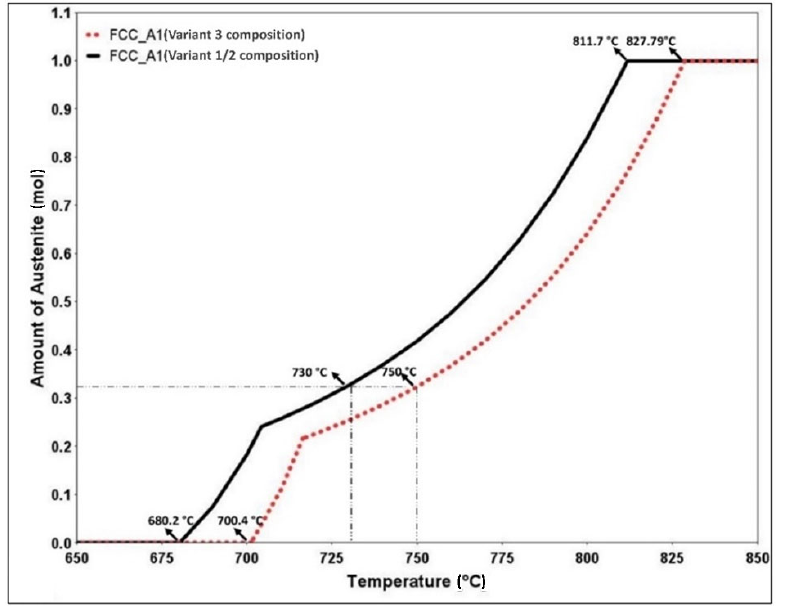
Figure 9. Comparison of the equilibrium austenite fractions for Variant 1/2 composition and Variant 3 composition predicted by ThermoCalc.